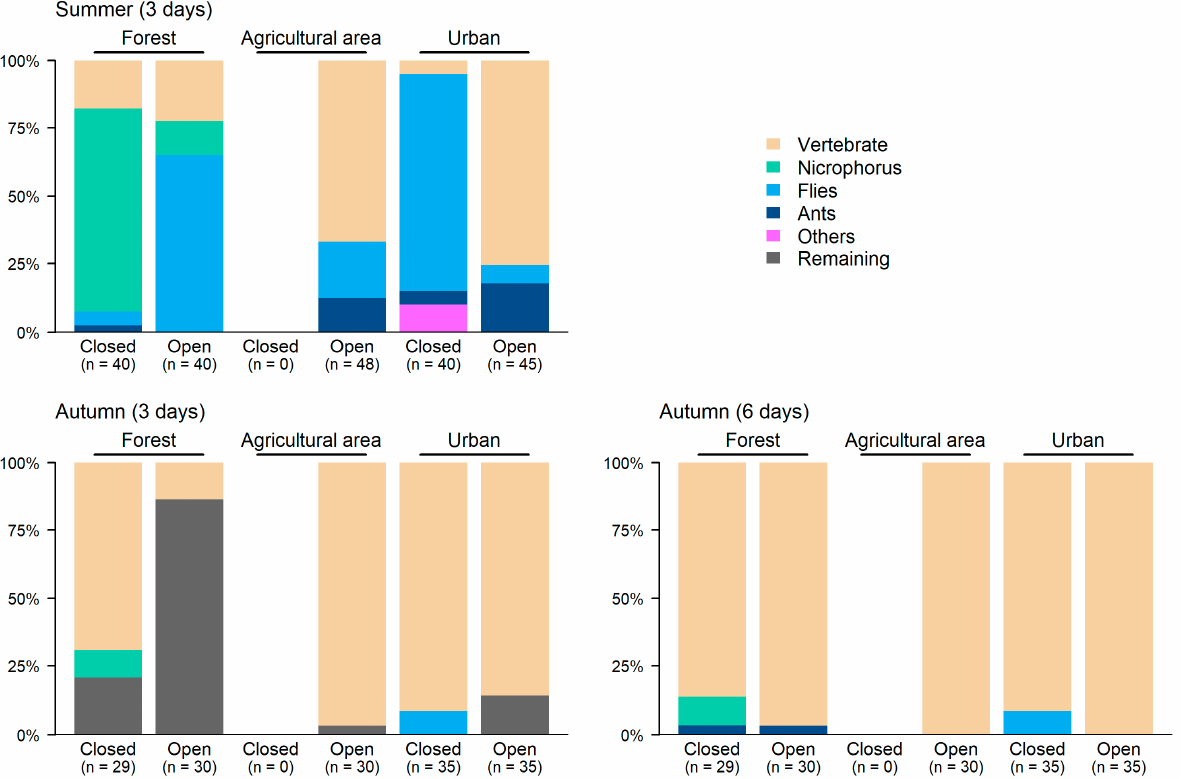
Figure 3. Percentage of scavenger groups of small mammal carcasses established at each survey